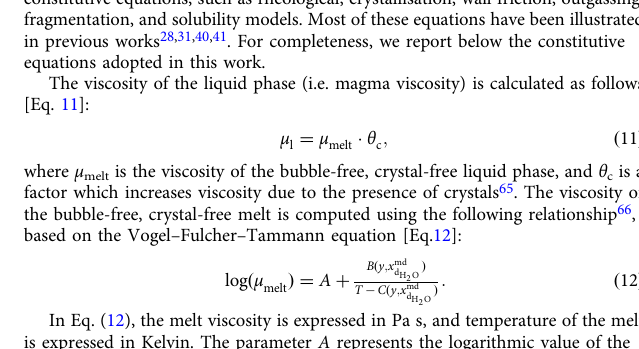
between the two phases.